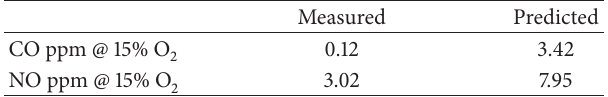
Table 3: Combustor exit CO and NO mass fractions for